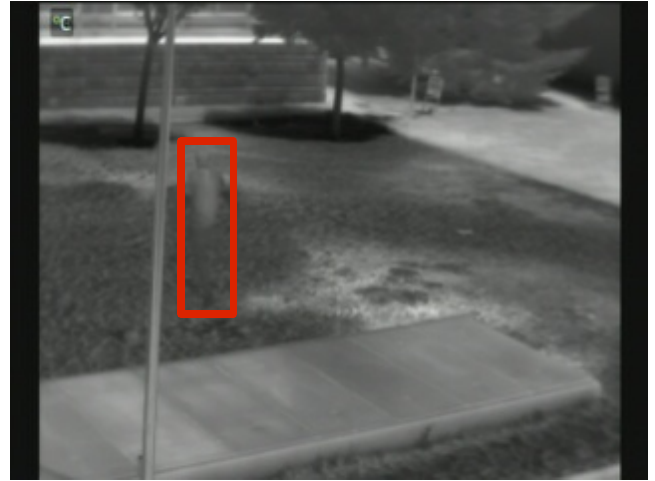
Figure 4. An example of a human being hard to detect in the thermal infrared